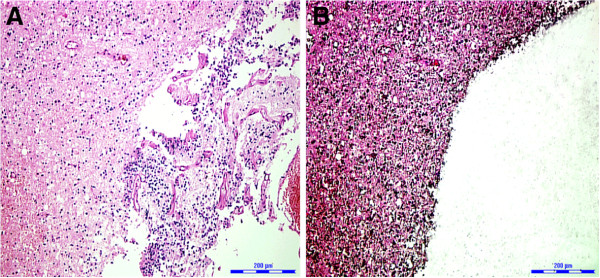
Representative H&E stained brain tissue sections of the same individual diagnosed as mixed anaplastic oligoastrocytoma (AOA). (A) Before laser microdissection and (B) after laser microdissection. ×100.